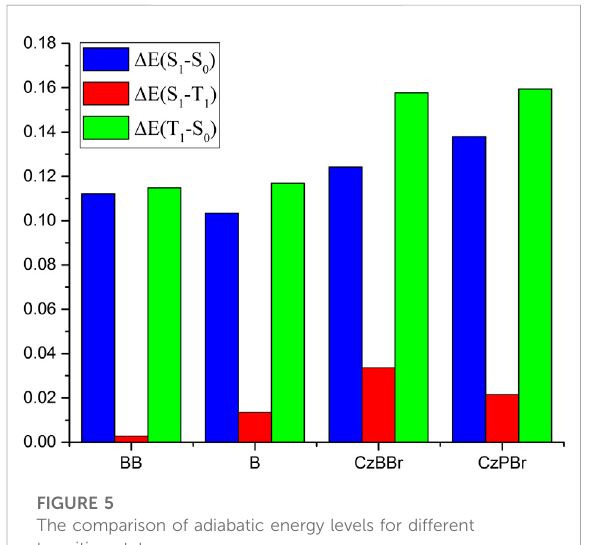
FIGURE 5 The comparison of adiabatic energy levels for different transition states.